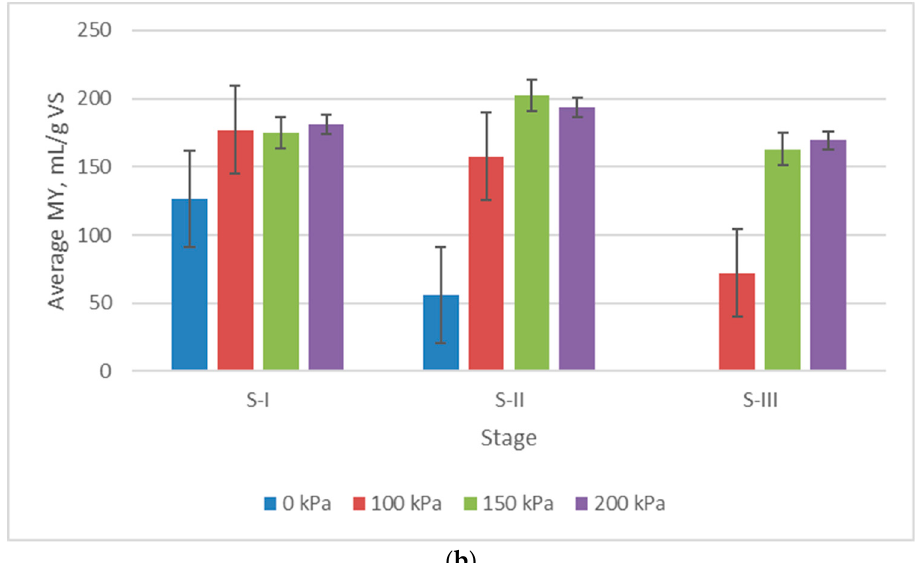
Figure 6. Dynamics of methane yield (MY) ( a ) and its average value ( b ) depending on the overpres- sure and HRT in the digesters.